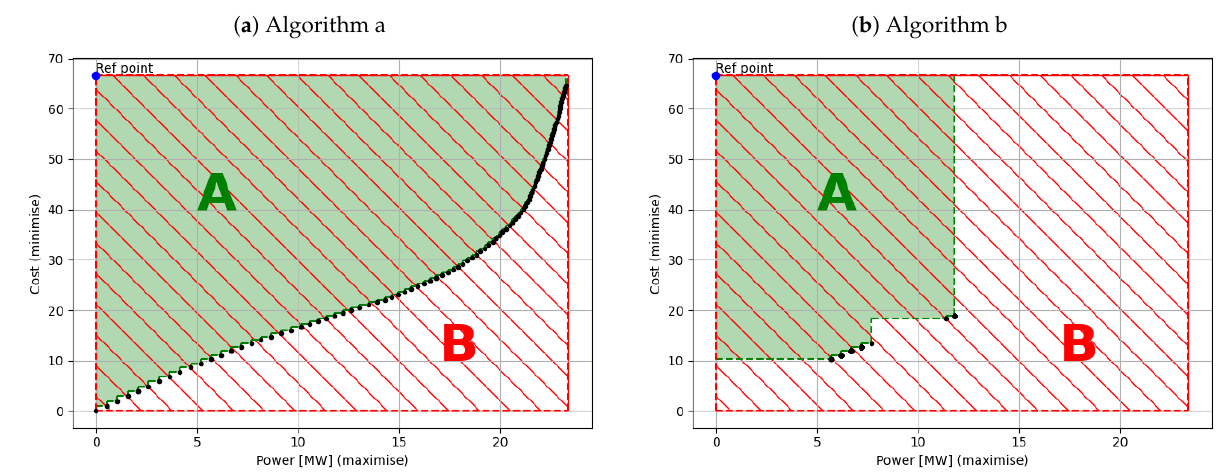
Figure 6. Performance comparison of two algorithms for the same number of function